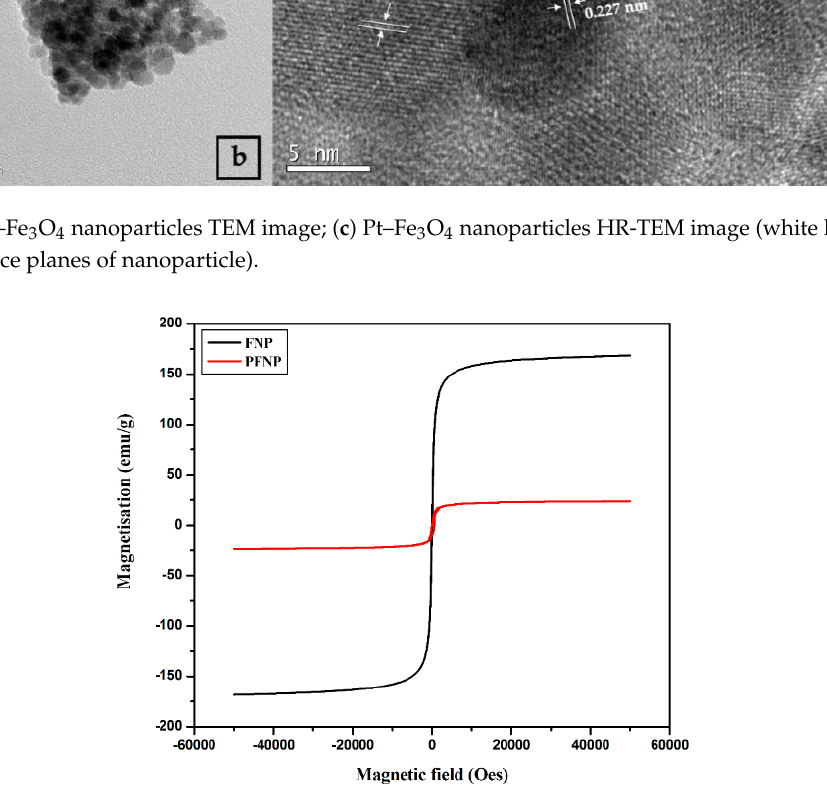
Figure 1. ( a , b ) Pt–Fe 3 O 4 nanoparticles TEM image; ( c ) Pt–Fe 3 O 4 nanoparticles HR-TEM image (white line indicates the gap between two lattice planes of nanoparticle).